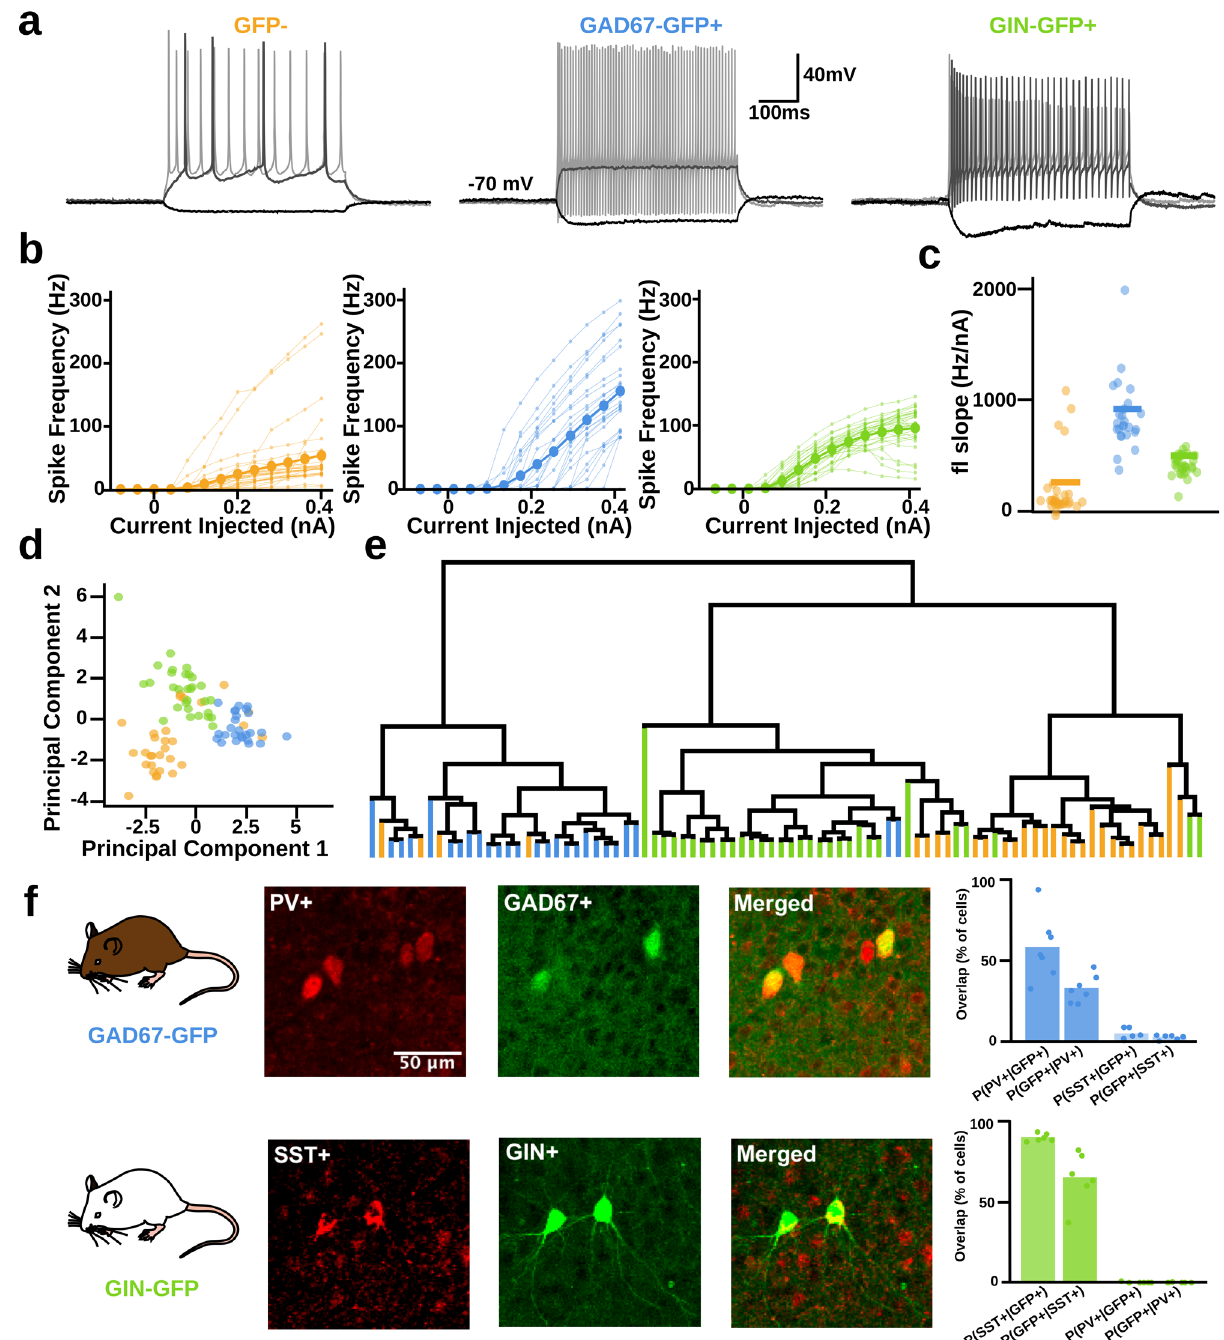
Fig. 1 GAD67-GFP and GIN-GFP mice target distinct populations of neurons, FS, mostly PV + , and SST + interneurons, respectively. a Sample electrophysiological traces from each cell type to current injections − 80 pA, + 160 pA, + 400 pA (darkest to lightest). b Frequency vs. current injection (f – I) curves for each cell type. Larger circles represent mean values. c Mean slope of the f – I curves for each cell type. Horizontal lines represent mean values. d 2 Component PCA of each cell type ’ s electrophysiological characteristics. e Dendrogram clustering. f Sample immunohistochemistry images from both transgenic fi rst principal component. The loadings for the fi rst principal component suggest that this dimension mainly captured the linear fi ltering and fast-spiking properties of cells ([feature: loading]; f – I slope: 0.46, membrane time constant ( τ ): − 0.46, spike halfwidth: − 0.43, rheobase: 0.32, cell capacitance: − 0.30, spike amplitude: − 0.23, spike threshold: − 0.22, input resistance: − 0.22, adaptation ratio: 0.21, sag amplitude: − 0.06). In other words, cells further along the fi rst principal component tend to